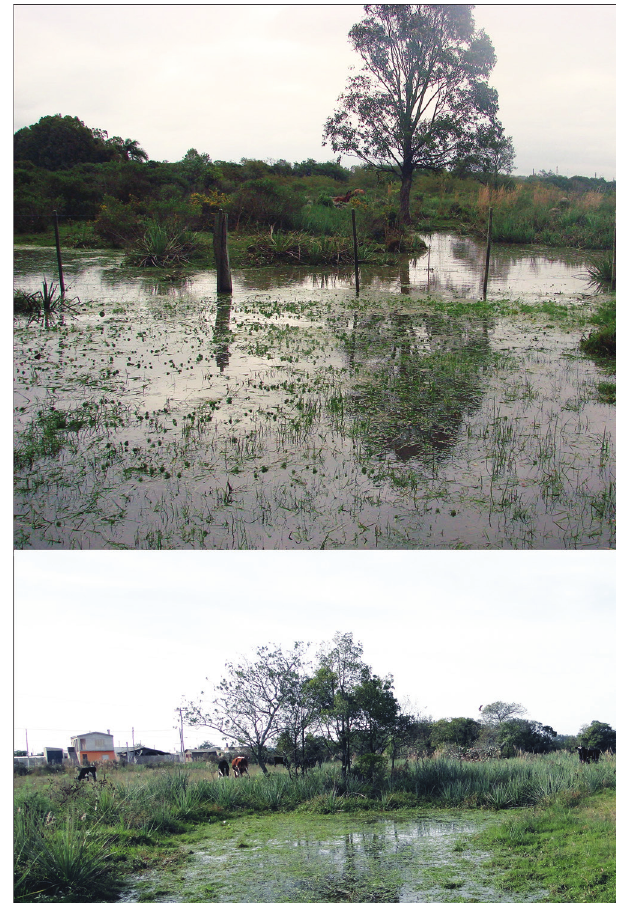
Fig. 3. Temporary ponds (Site 1 above and Site 2 below) inhabited by Austrolebias cheradophilus in lowlands of Jaguarão River basin, southern